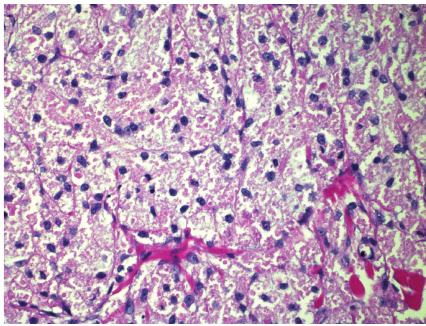
Figure 3: H&E, 400x